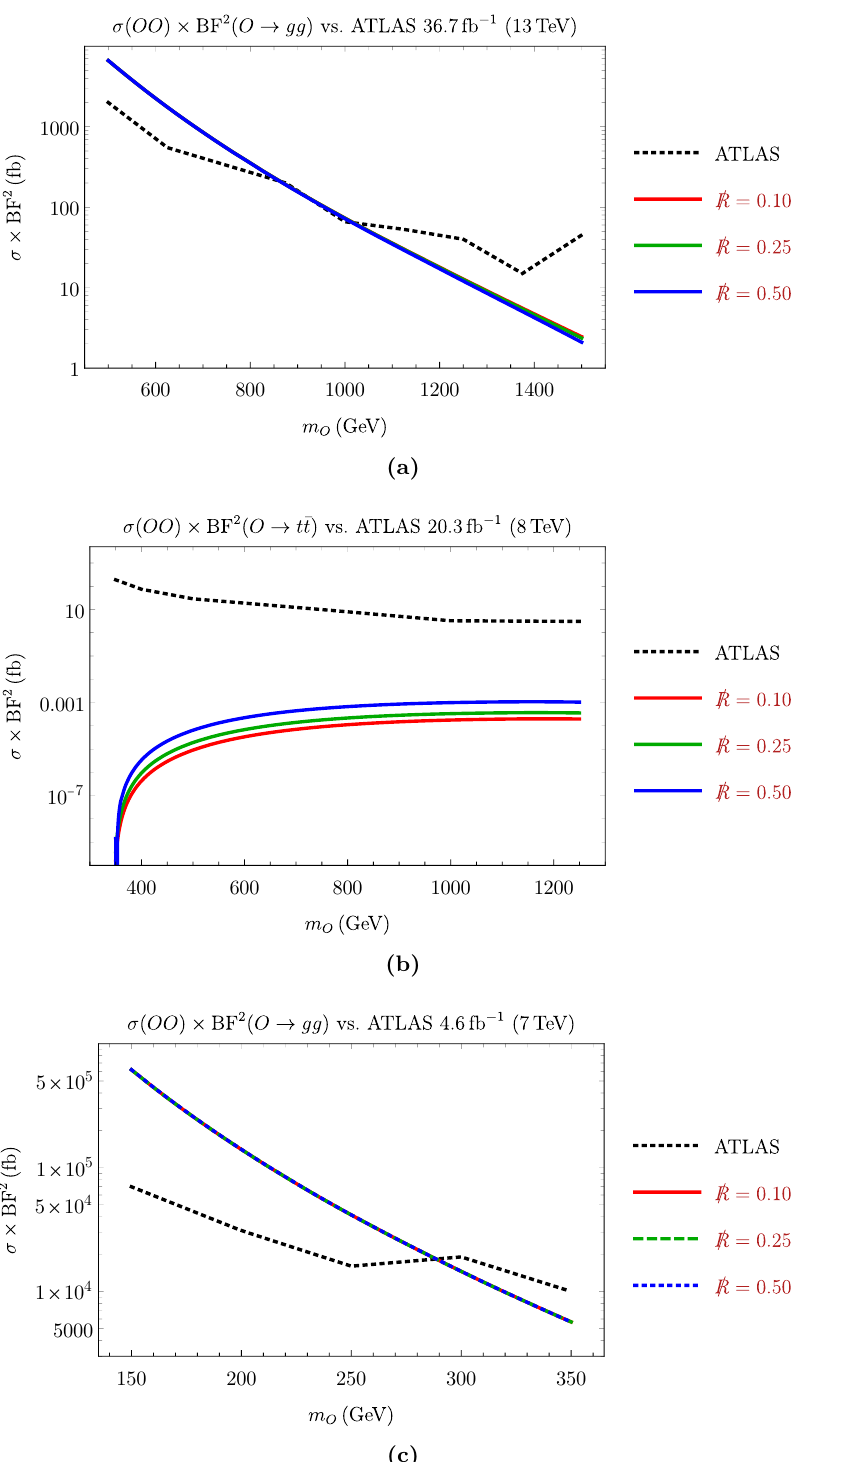
Figure 12. Cross sections in Benchmarks 1–3 of scalar sgluon pair production, with subsequent decays to gluons or top-antitop pairs, compared to exclusion bounds from three ATLAS searches for color-octet